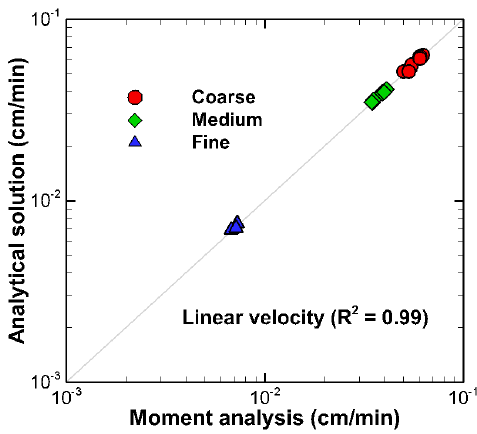
Figure 6. Comparison between the results of analytical solution and moment analysis: Pore water velocity (cm/min).